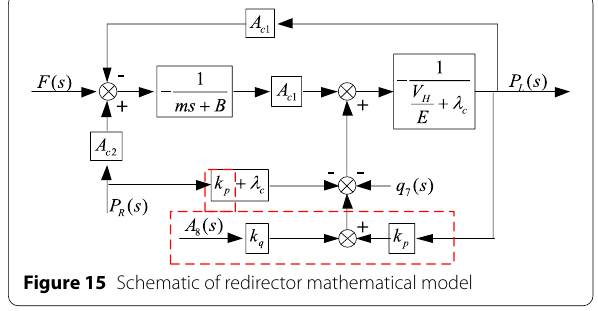
Figure 15 Schematic of redirector mathematical